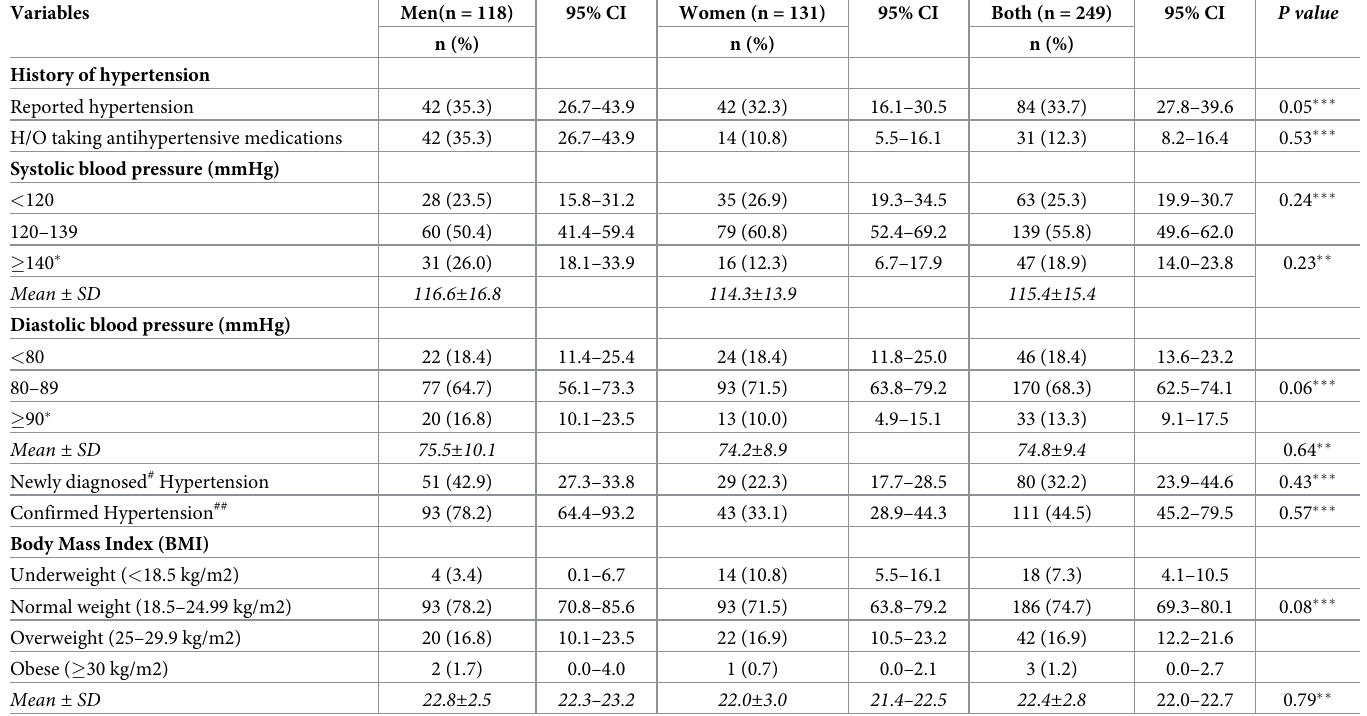
Table 3. Measured risk factors of the respondents (n = 249).